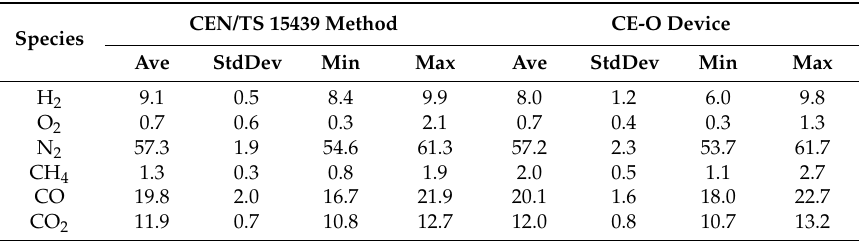
Table 3. Comparison of gas composition using the impingers and CE-O sampling